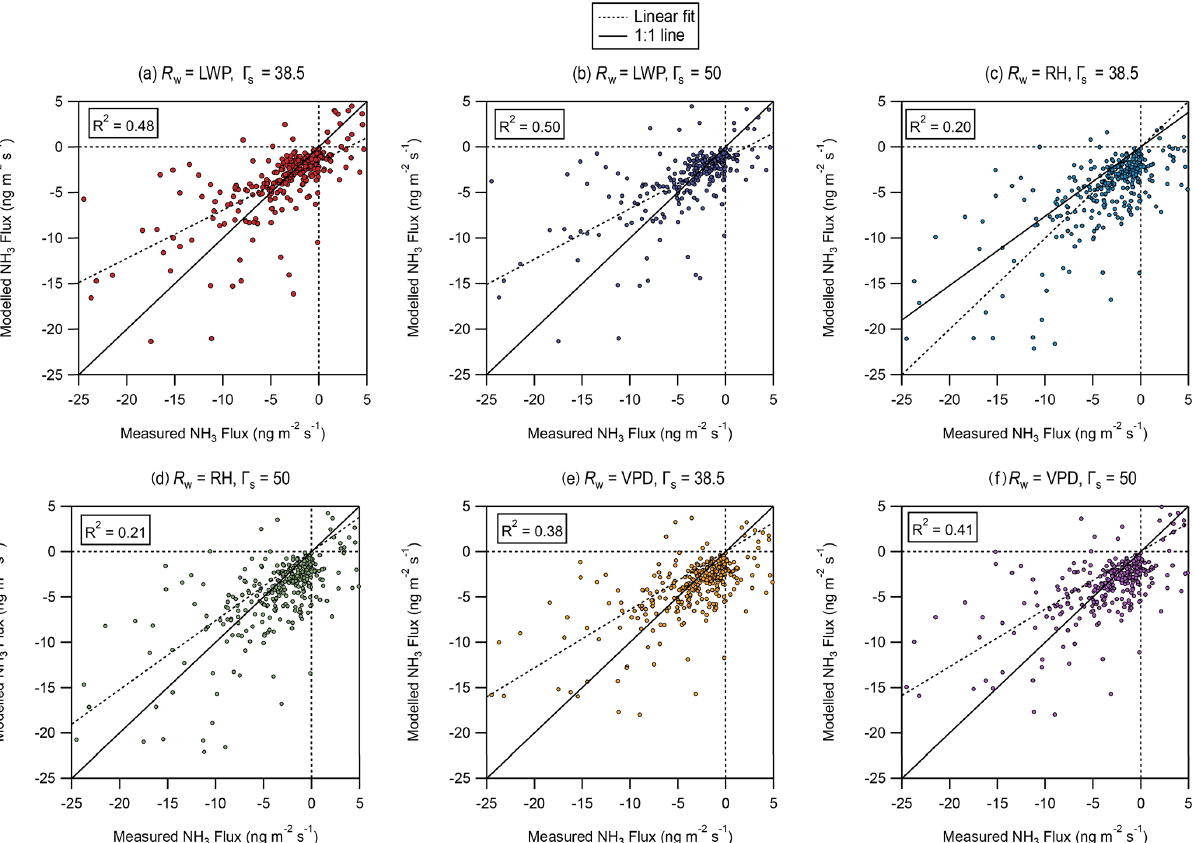
Figure 5. Linear regressions between measured NH 3 fluxes and six models (a–f) of NH 3 fluxes differing in the approach used to derive a value for the cuticular resistance R w and in the value used for the apoplastic ratio (cid:48) , as noted above each